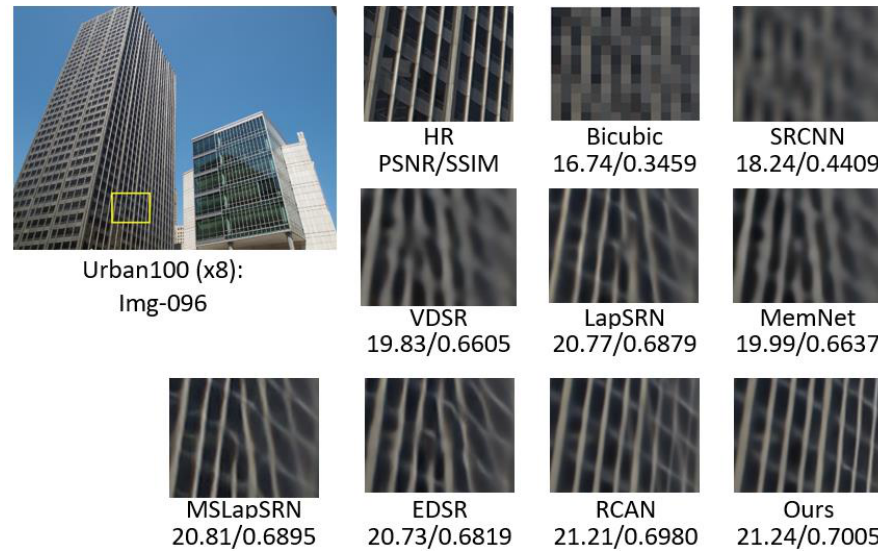
Figure 15. Visual comparison of image “Img-096” at × 8 scale on the Urban100 dataset. The quantitative results comparison using PSNR (dB) and SSIM evaluations at × 2, × 4, and × 8 scales on Set5 [58], Set14 [59], BSD100 [60], Manga109 [61], and Urban100